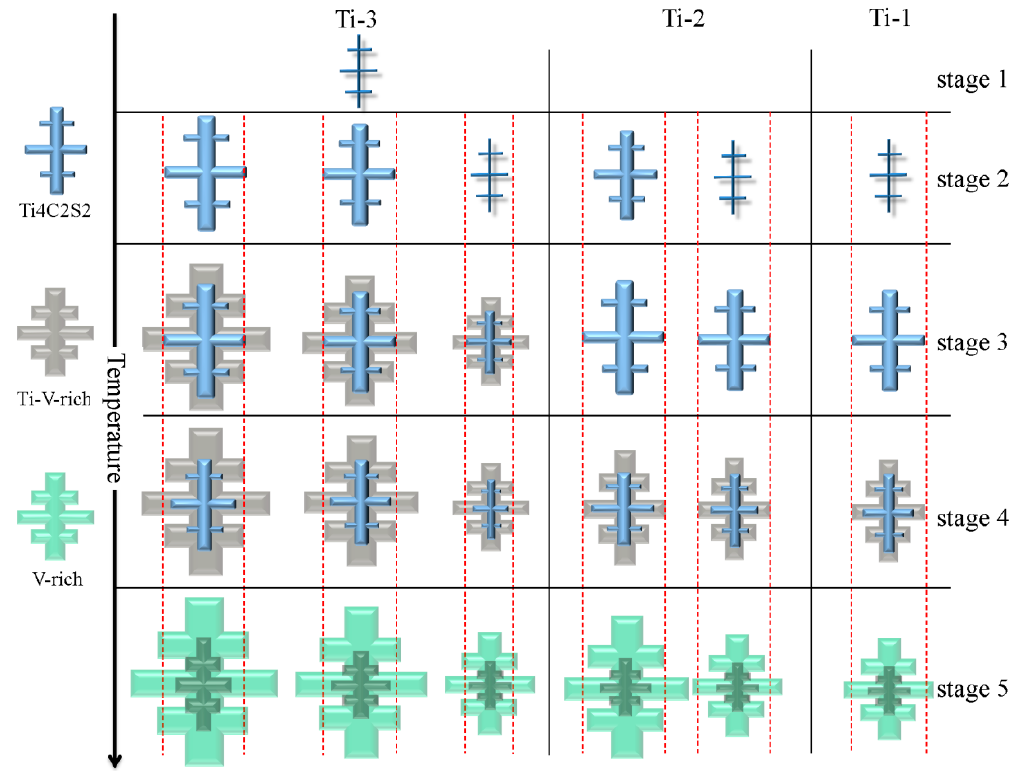
Figure 15. Schematic diagram of the precipitation process of primary carbides during solidification.